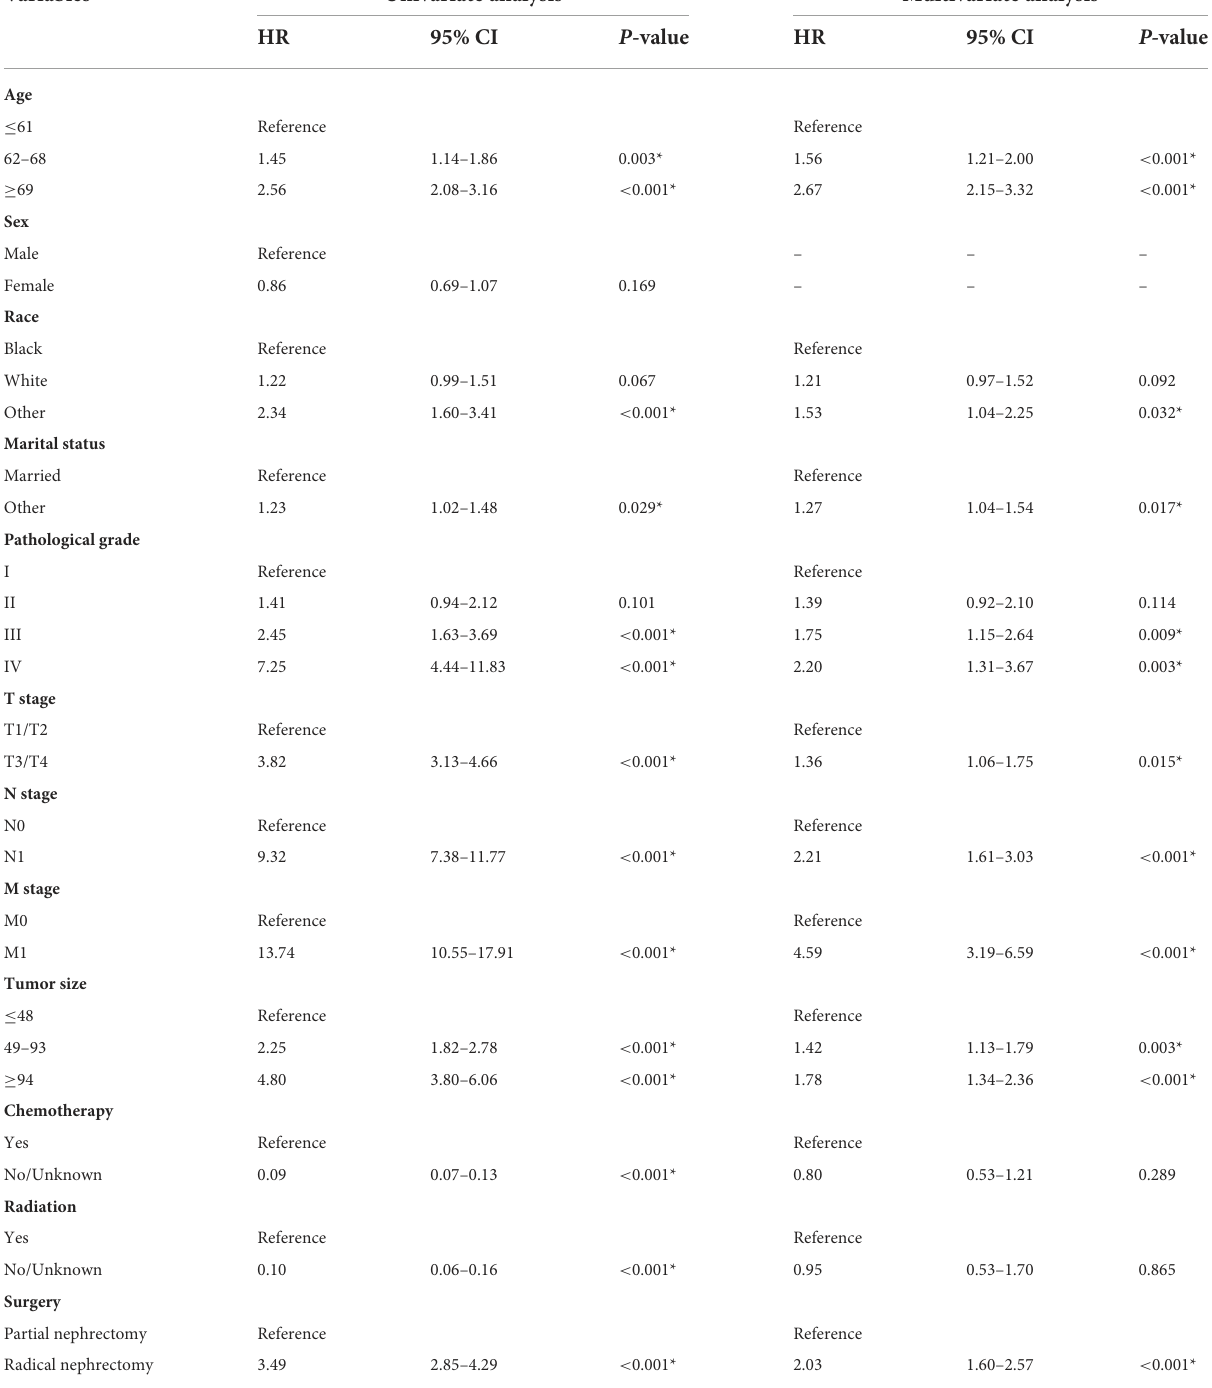
TABLE 2 Univariate and multivariate Cox analyses of the training cohort on overall